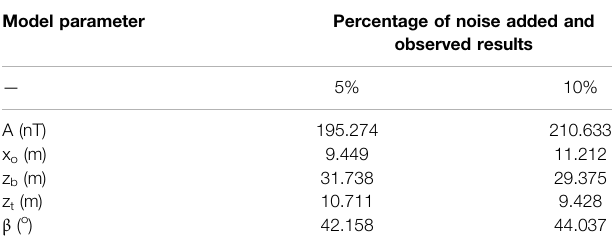
TABLE 6| Searchspace,actual andestimated parametersforsyntheticmagnetic anomaly corrupted with random noise. Model